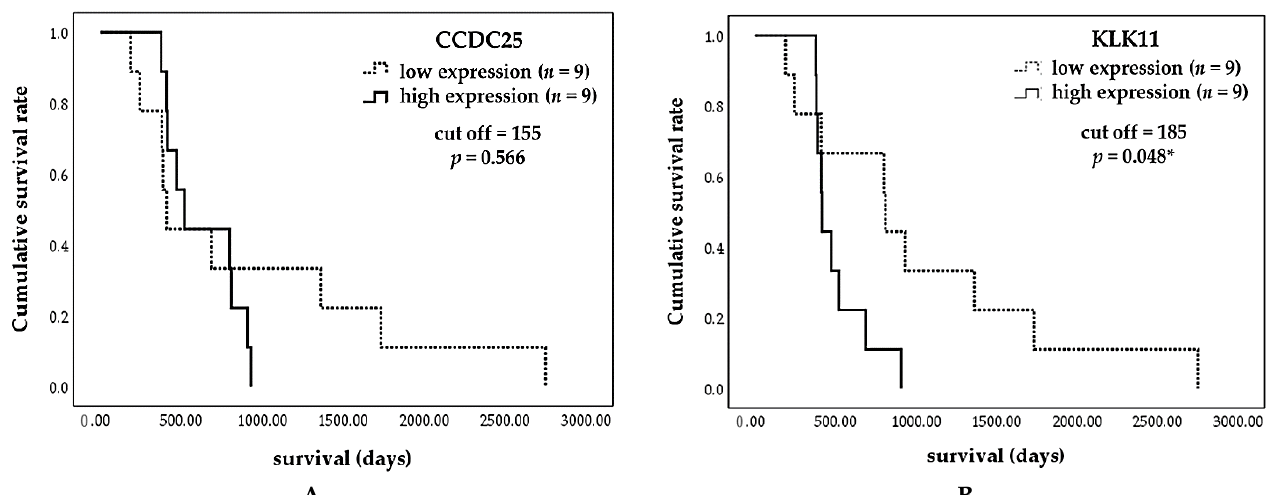
Figure 5. Kaplan–Meier survival curves of CCA patients based on H-score of CCDC25 and KLK11. CCA patients were divided into low- and high-expression using median values as cut-off for CCDC25 and KLK11 (155 and 185, respectively). The curves show overall survival of CCA patients having high expression (solid line) and low expression (dashed line). The survival times were observed between low- and high-expression groups of ( A ) CCDC25 and ( B ) KLK11 (log-rank test; p = 0.566 and p = 0.048, respectively ) . * Statistical significance ( p < 0.05).